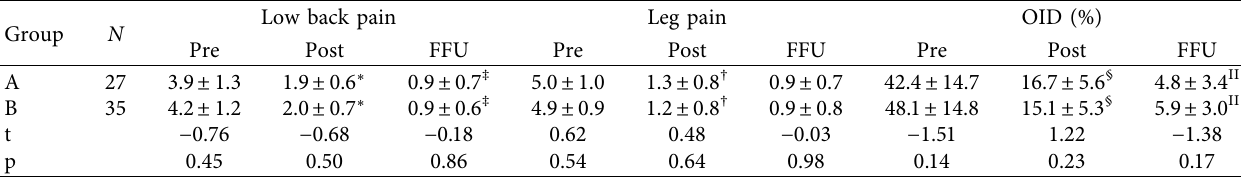
Table 1: Clinical outcomes.